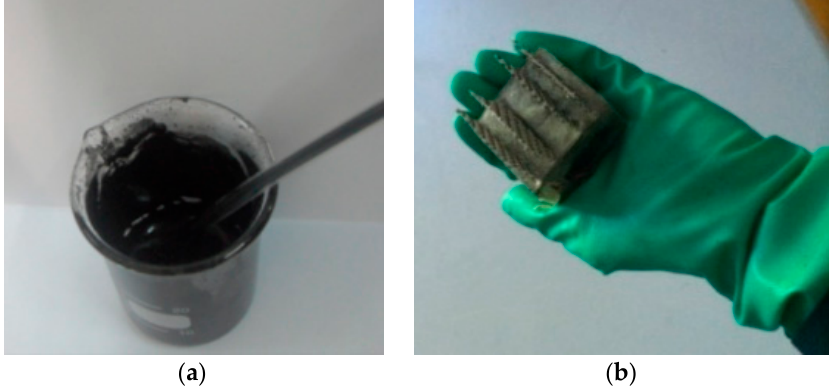
Figure 1. Smart concrete: ( a ) Dispersion of MWCNT in water for preparation of smart concrete; ( b ) Cubic sensor made of smart concrete doped with